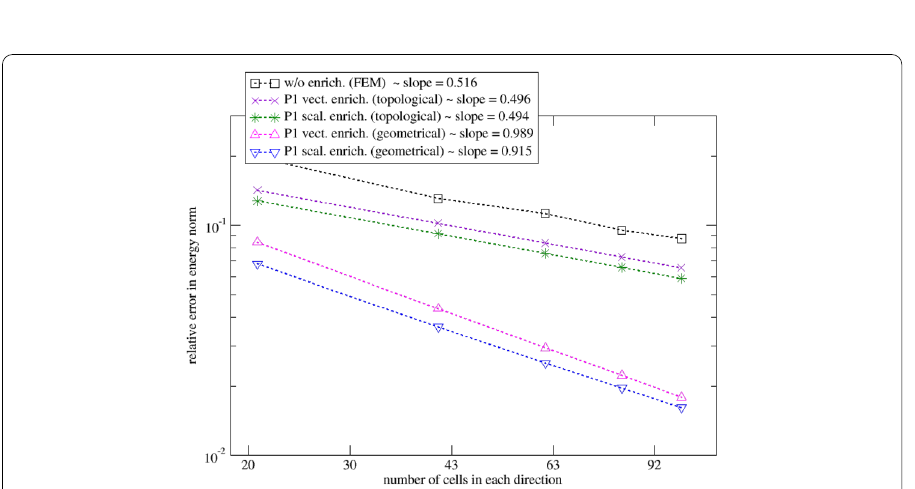
Fig. 22 Convergence analysis of crack approximation spaces. The single-layer enrichment (topological) convergence curves are added to recall the benefit of the geometrical enrichment strategy